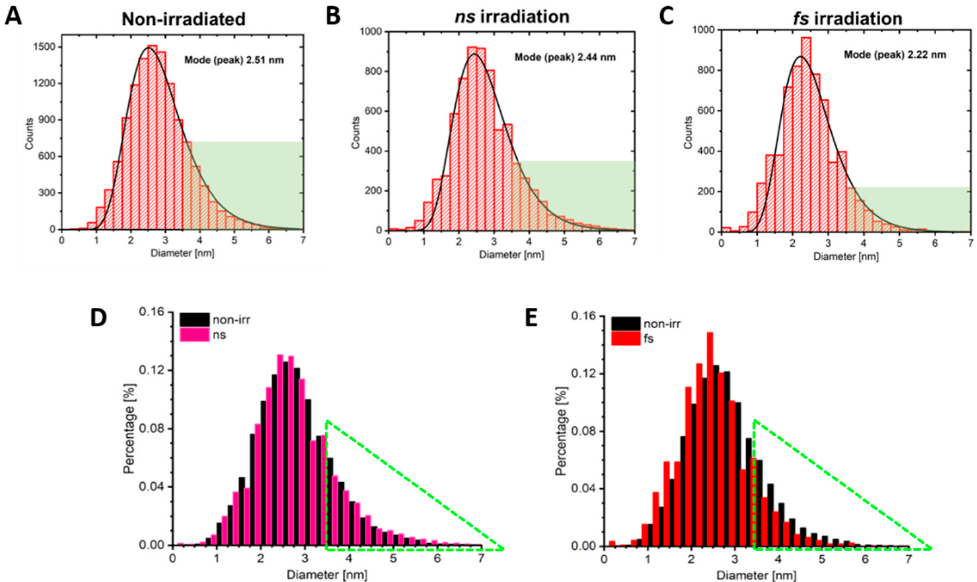
Figure 4. AuNP size distributions following vesicle irradiation. ( A – C ) The diameters of AuNP populations within polymersome membranes were measured without irradiation, and after ns and fs irradiation, respectively. The green shaded area highlights NPs with diameters greater than 3.5 nm. ( D , E ) Comparative population overlays for irradiated vs. non-irradiated samples. The green triangle highlights the size region of interest where particle fragmentation is apparent.